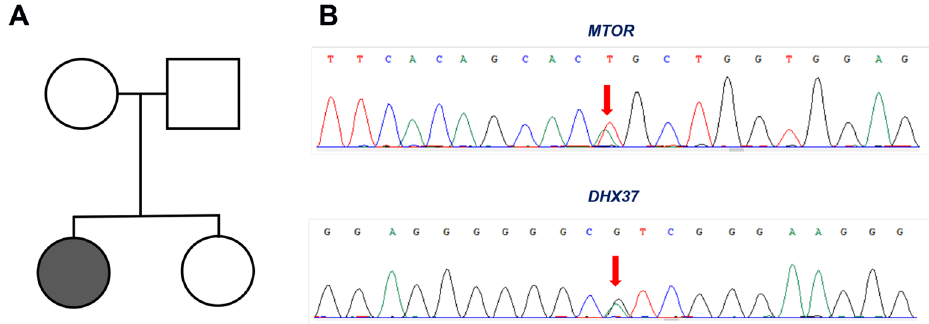
Figure 1. Variation characteristics of two gene loci. ( A ) The genetic map of the patient’s family showed that there was only one case of Parry–Romberg syndrome in the patient’s family. ( B ) The Sanger sequencing verification results of the patient’s sister showed that the patient’s sister also had the same genetic locus mutation.